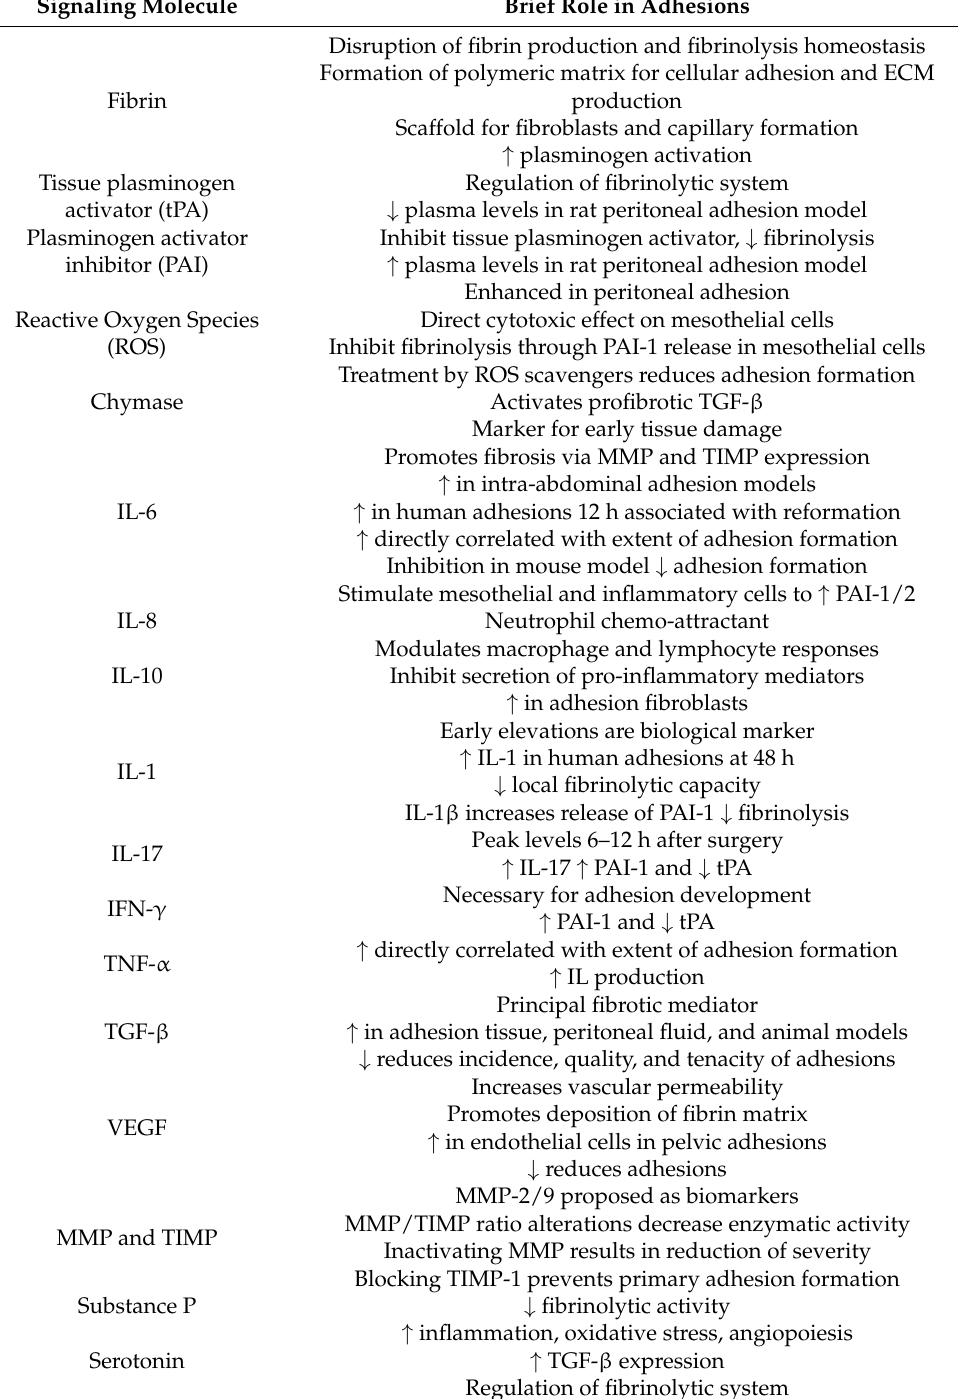
Table 2. Soluble mediators and their role in adhesion